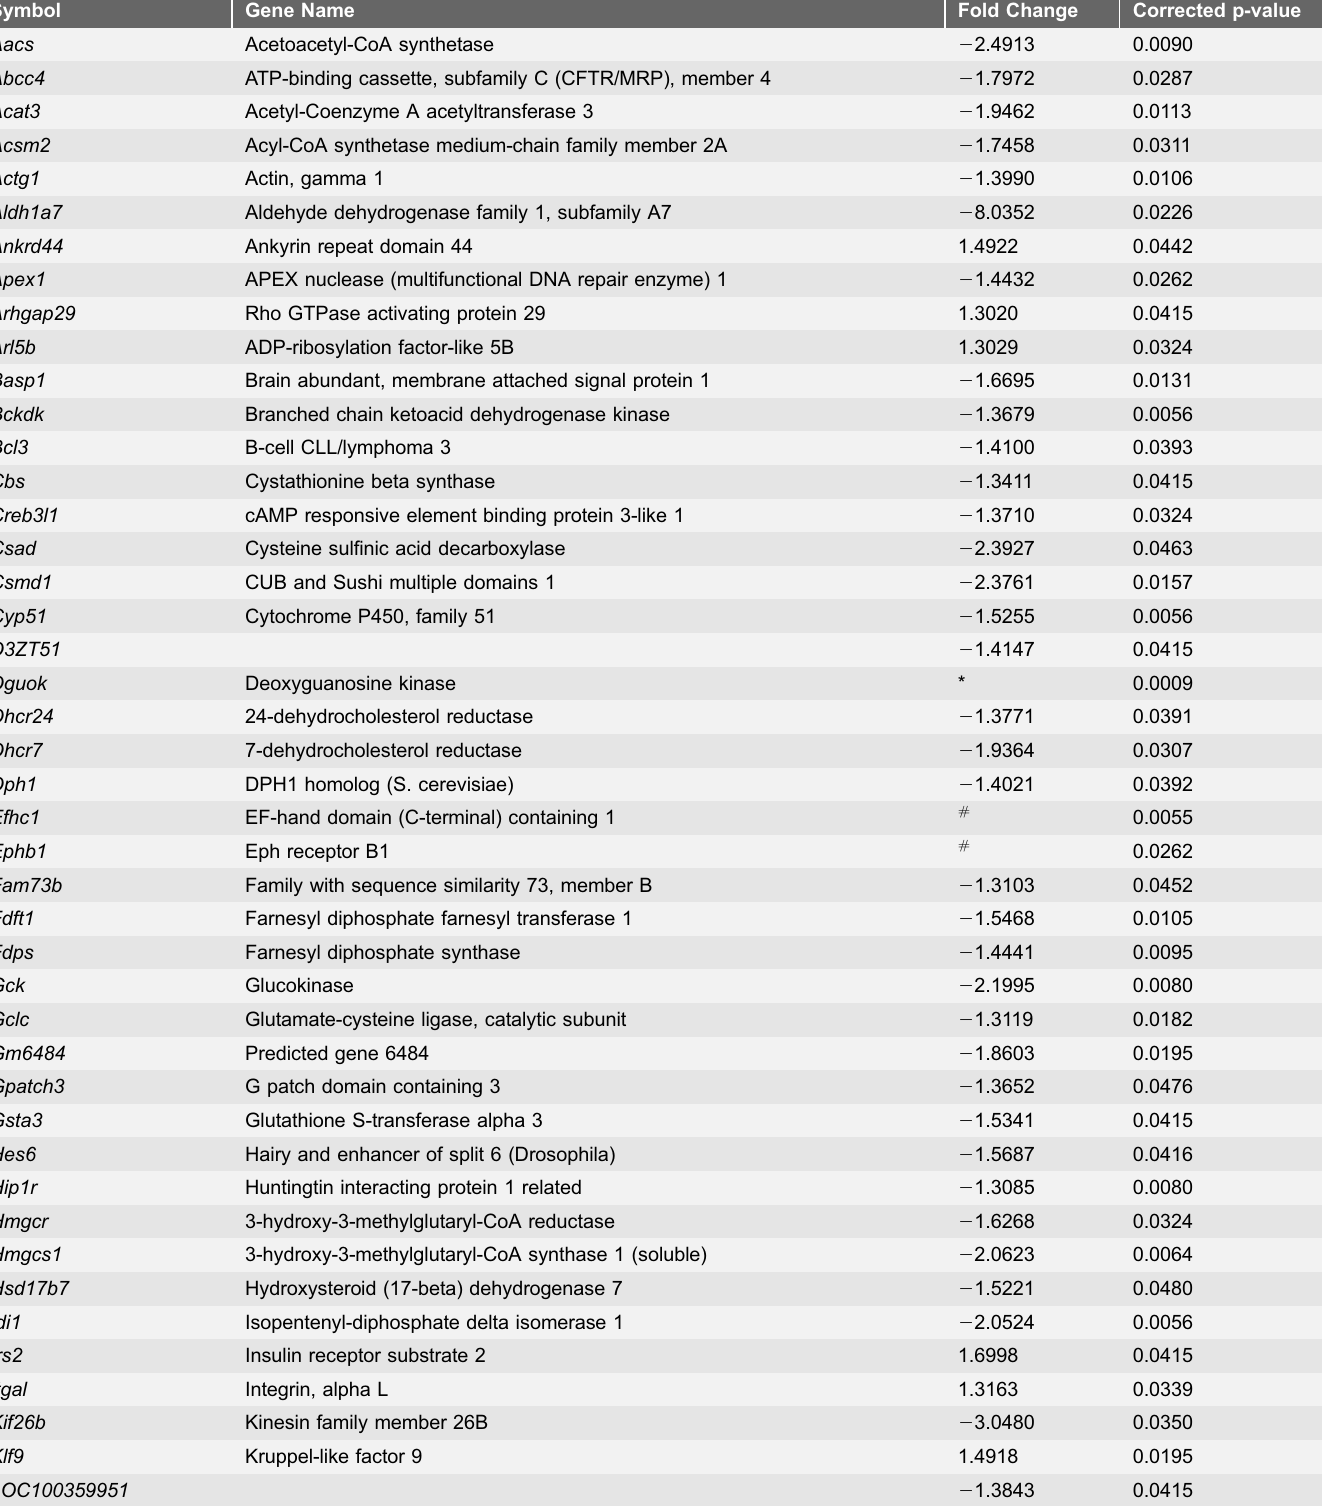
Table 1. Genes with ¡ 1.3 or greater fold change after chronic ethanol